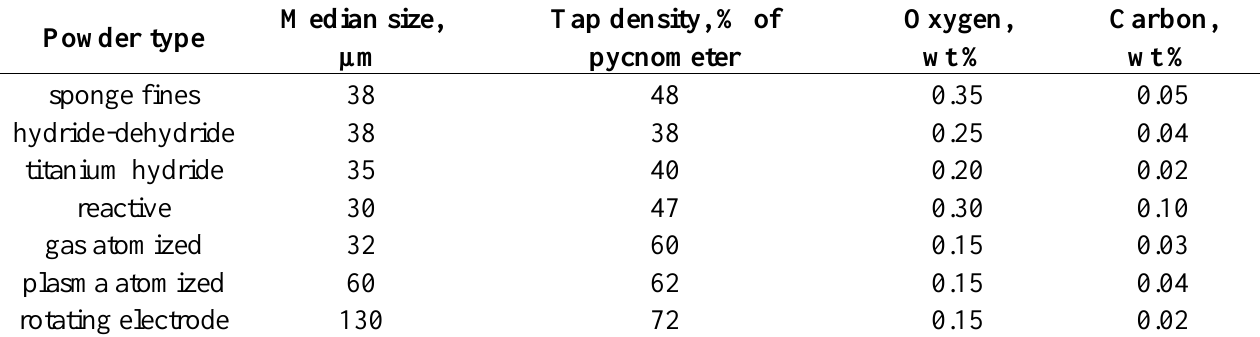
Table 2. Characteristics of titanium powders used for metal injection